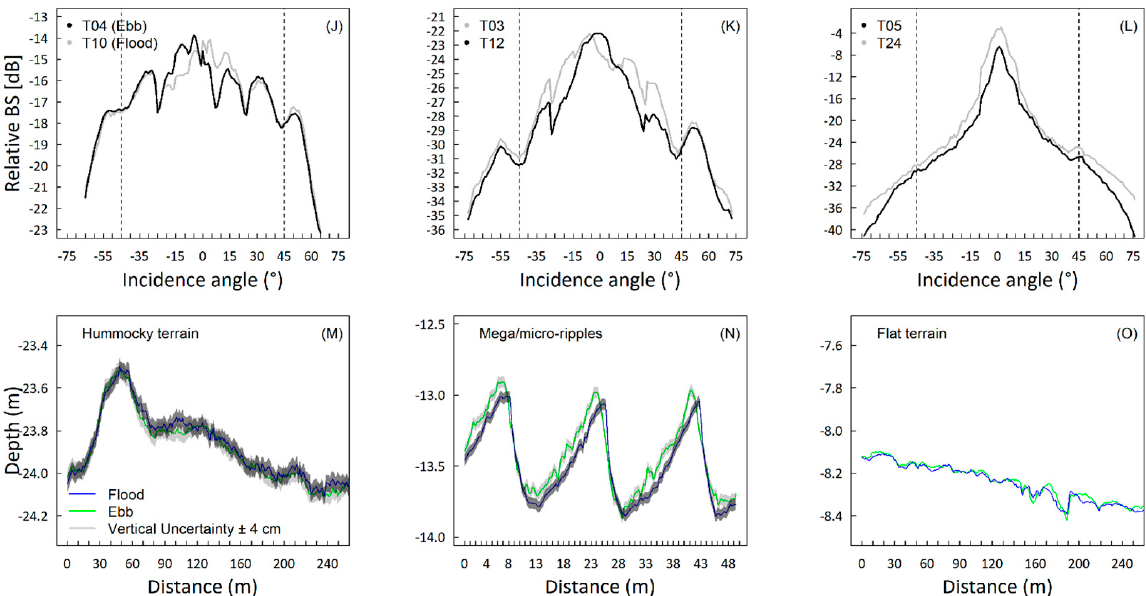
Figure 6. Synthesis of the backscatter time series acquired for each experiment. The first plot ( A – C ) is the envelope of variability (grey shading) around the average AR (black line) of the full AR BS time series, extracted from the defined ROIs. It describes the variability of backscatter intensity per angle of incidence over the duration of the experiments. The envelope is computed from n = 15, 19 and 47 MBES passes respectively for the 1st, 2nd and 3rd experiment. The processing scheme code for the AR BS dataset is “A4 B1, C2 D1 E5 F3 G2 H3 I0 J0 H2” using the nomenclature proposed in [11]. The second plot ( D – F ) is the same time series (though derived from the BS mosaics produced in FMGT ; BS 30-60° @ 300 kHz ) but visualized as boxplots of relative BS (values across the full incidence angle) against the time of acquisition (mean surveying time within the ROI). The overall mean over the full time series, together with the ±1 dB Kongsberg sensitivity threshold [66], are respectively shown as red and blue dashed lines. The tidal level is superimposed to assess a prospective BS trend in respect to the tidal oscillation and its phases. In the boxplots, lower and upper box boundaries are the 25th and 75th percentile respectively, the black central bar the median, whiskers denote the full extent of the data (i.e., min/max). The processing scheme code for the mosaicked BS dataset is “A4 B0 C0 D0 E5 F0” using the nomenclature proposed in [11]. The third plot ( G – H ) is the time evolution of the relative BS for areas insonified within a same envelope of incidence angle at a 5° resolution. This provides a more detailed depiction of the variability as a function of the incidence angle, to observe if smaller angular sectors would be less affected by the processes driving the variability. In ( G – H ), the blue to green palette represents angular intervals from the fall-off to the specular region in steps of 5°, leading to approximately 15 sub-sectors per experiment. The fourth plot ( J – L ) displays the AR curves at the peak flood and ebb tidal phases (the legend mentions the corresponding survey time) during the experiments and is used to establish the presence of roughness-polarization dependence (as proposed in [27,36]). The fifth plot ( M – O ) displays bathymetric profiles extracted at nadir within the ROIs at the same peak flood and ebb tidal moments as the previous plot ( J – L ). For the Kwinte swale and Westdiep experiments, using the EM3002D echosounder, the ±4 cm vertical accuracy interval is displayed as a grey/transparent envelope.